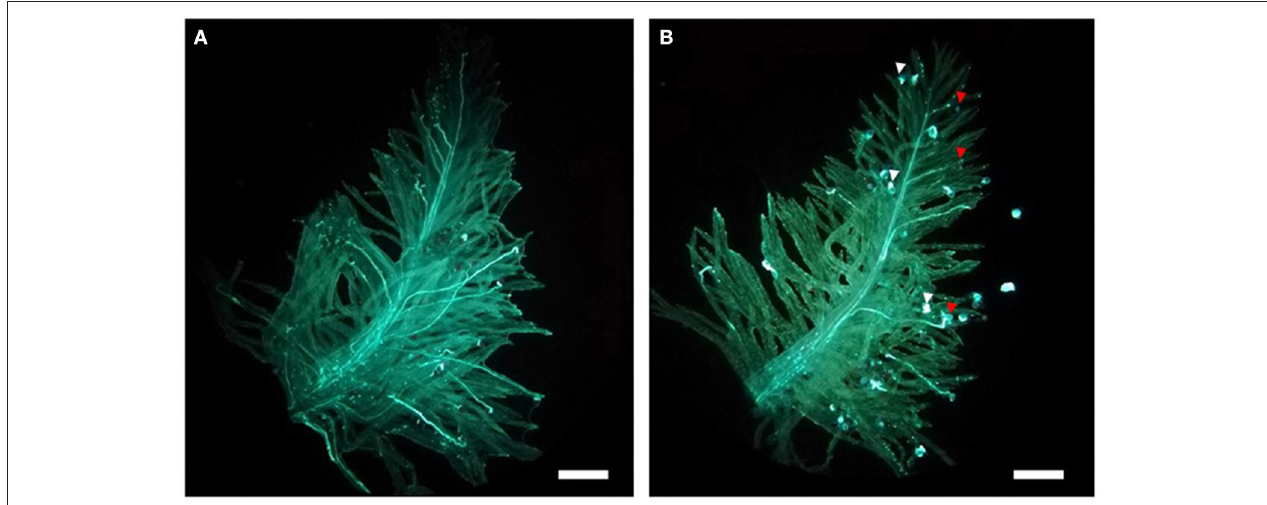
FIGURE 1 | The two self-compatibility (SC) phenotypic classes segregating in the F 2 population as visible in an in vitro pollination assay. (A) In genotypes showing 100% SC, all pollen grains form a pollen tube that is able to elongate within the stigma reaching the ovary. (B) In genotypes showing 50% SC, only half of the pollen grains penetrate the stigma and elongate a pollen tube (indicated by the red arrows). For the remaining half, pollen tube growth is aborted upon contact with the stigma and followed by rapid deposition of callose at the pollen tube tip (white arrows). Bars: 400 µ